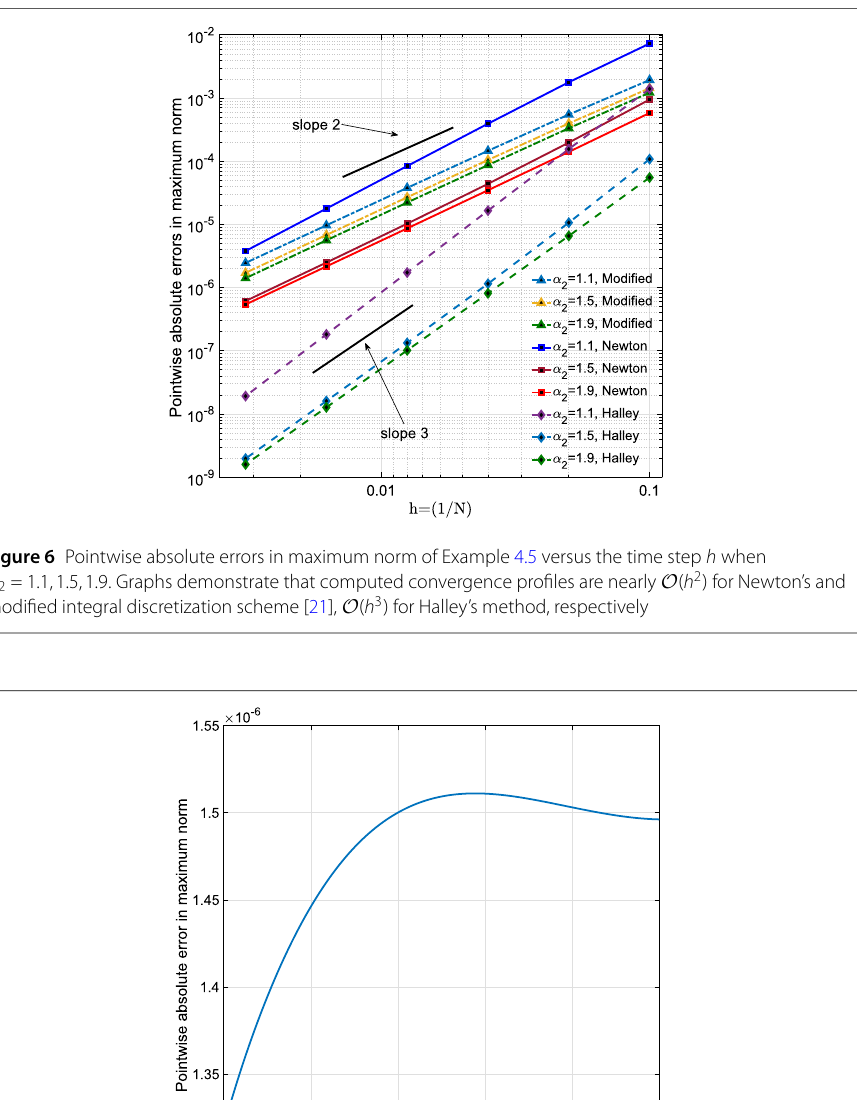
(b) the proposed shooting technique based on Newton’s method with linear